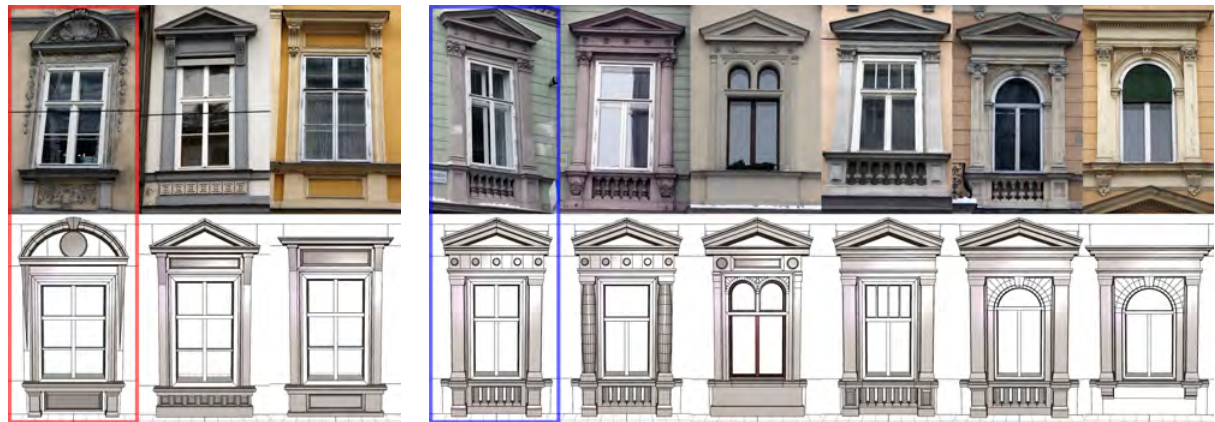
Figure 9: Variations of the two windows in red and blue frames from Figure 8. The variations are derived only by replacing assets and manually adjusting proportions. Assets can be combined to realize also more challenging configurations (right group, third variation).